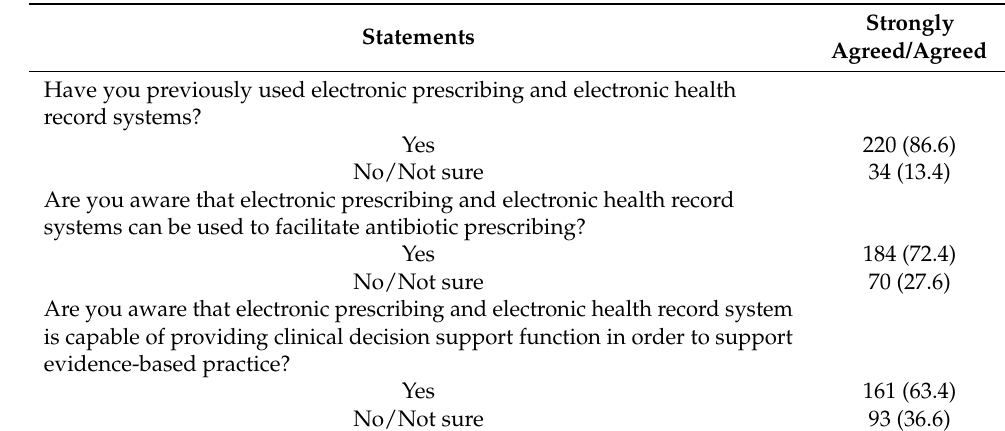
Table 2. Participants’ awareness about the use of electronic prescribing and electronic health record systems in antimicrobial stewardship ( n = 254).